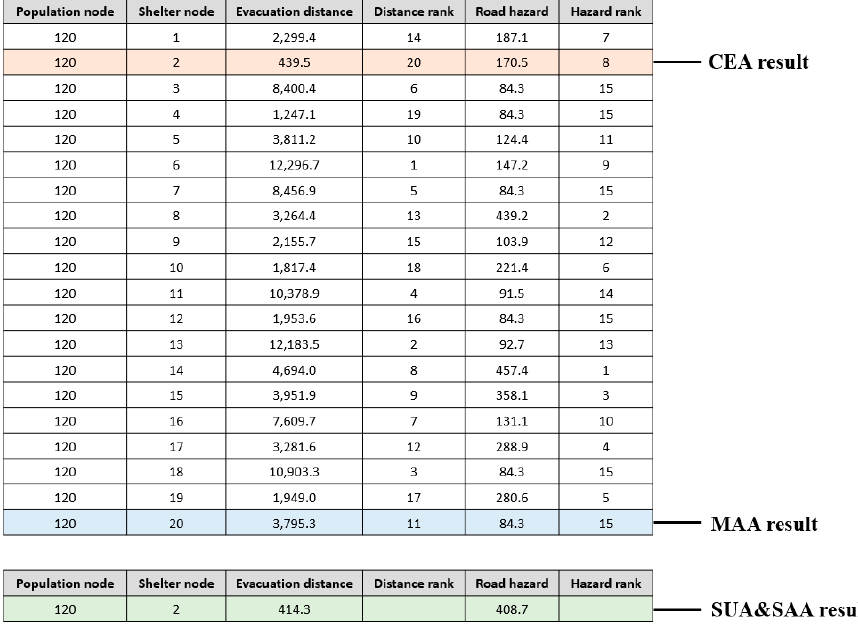
Table 3. Summary of results of evacuation route analysis. Analysis type